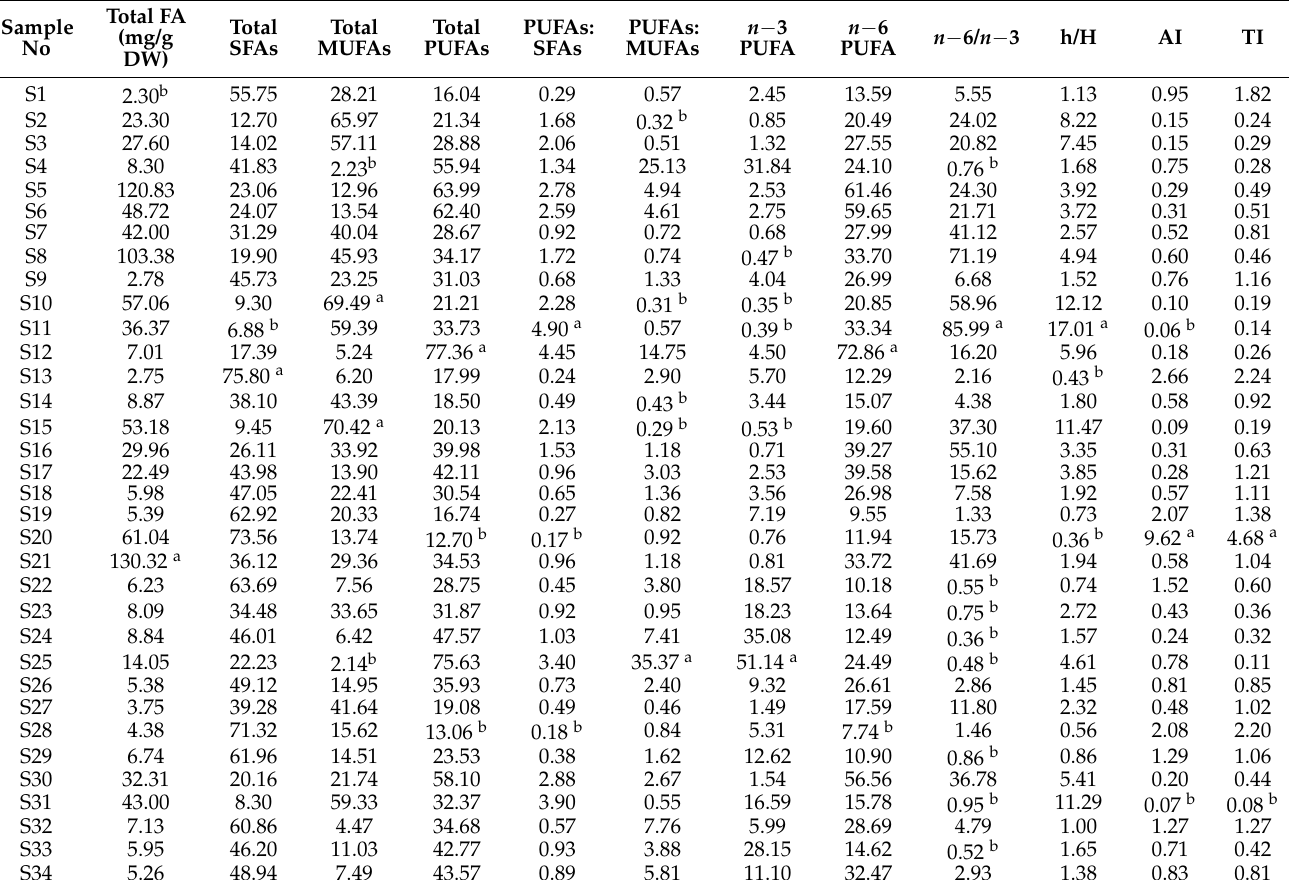
Table 3. The fat quality indices of lipids of spices and